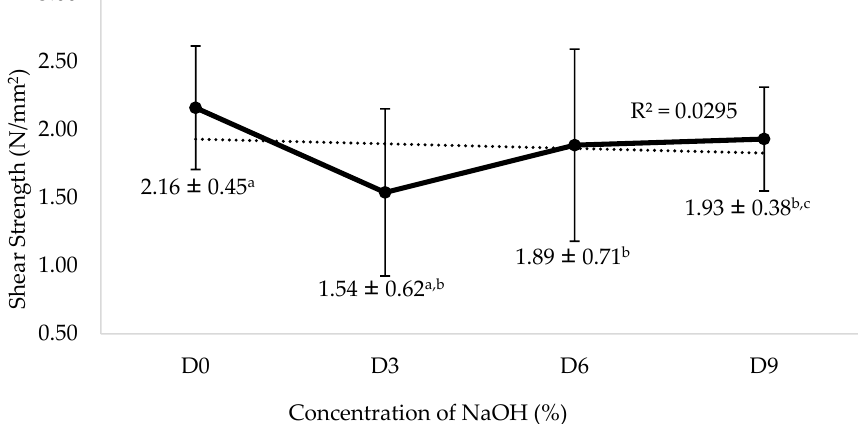
Figure 4. Mean values and standard deviations of shear strength of untreated (D0) and alkaline treated (D3, D6, and D9) densified Paraserianthes falcataria glulam with different alphabets (a, b, c, and d) indicating a significant difference at p ≤ 0.05 .